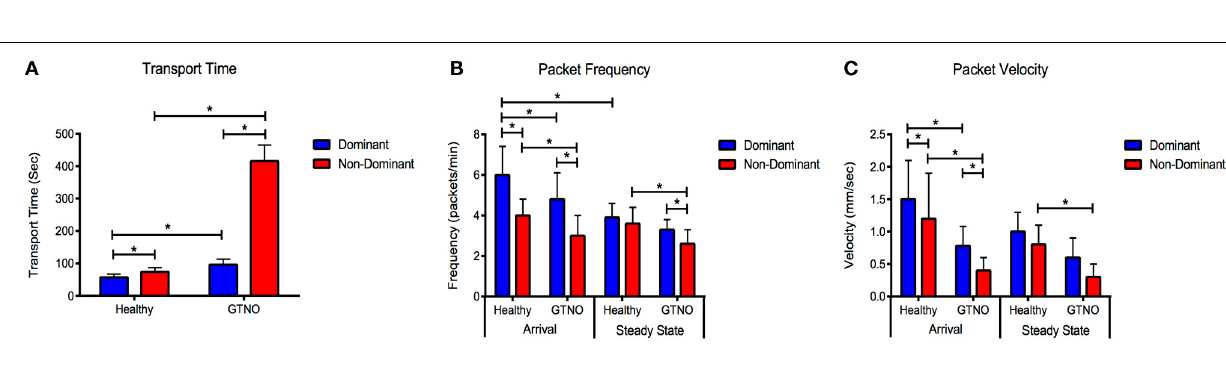
non-dominant vessel during arrival and steady-state segments in healthy and GTNO-treated animals ( n = 3). Error bars represent standard deviation. ∗ p < 0 . 01.